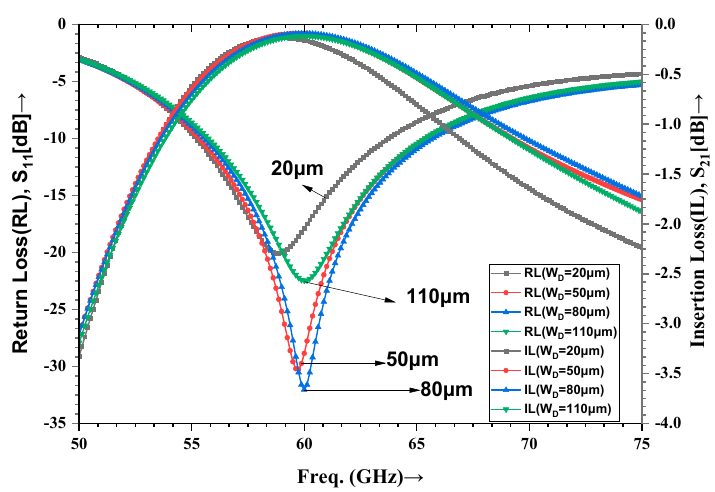
Figure 5. Effect of variations of dipole antenna length on RL and IL plots. Table 4. Dipole antenna arms’ width